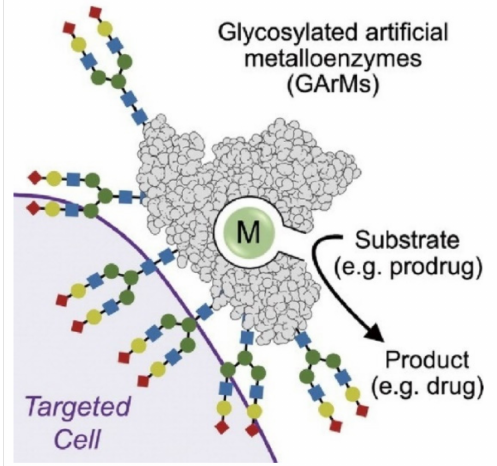
Figure 24. Glycosylated artificial metalloenzymes nanoarchitected based on in vivo synthetic chem- istry; designed glucans are covalently introduced onto base protein. Reprinted with permission from Reference [169]. Copyright 2020 Chemical Society of